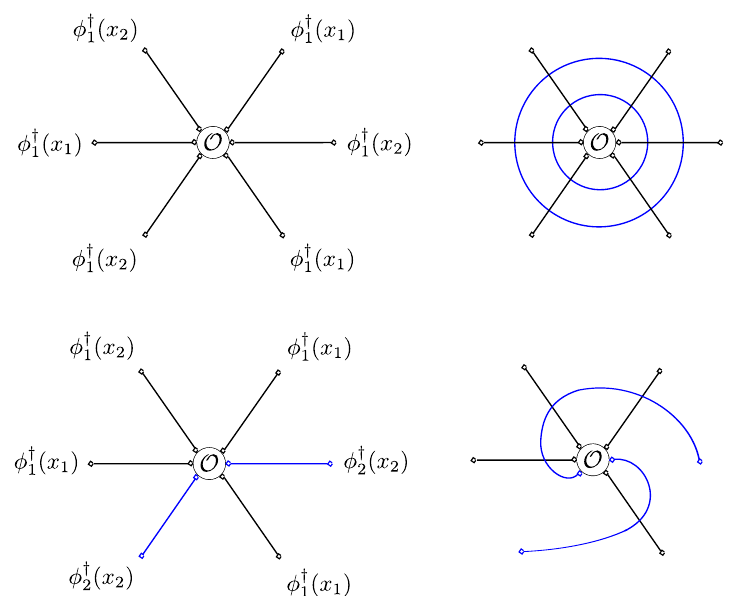
Figure 3 . A class of Feynman graphs in the expansion of the three-point function of (4.19)–(4.21). For the BMN “vacuum” O = tr( φ 1 ) 6 : tree level (top left) and a globe graph (top right). For the two-magnon trace O = tr(( φ 1 ) 3 φ 2 φ 1 φ 2 ) : tree level (bottom left) and an unwrapped spiral graph (bottom